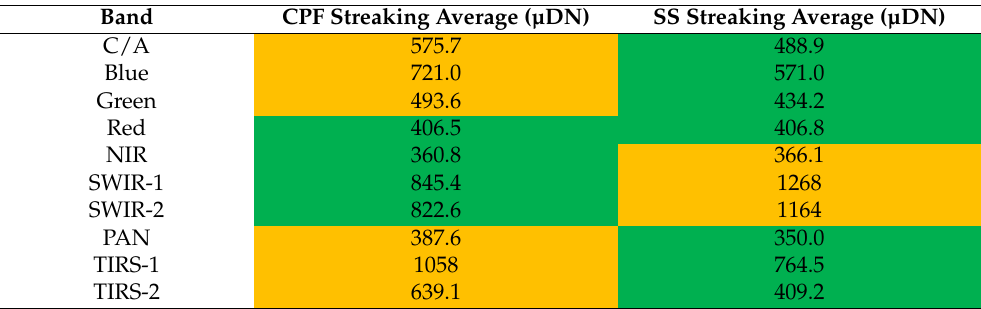
Table 6. Average Streaking Metrics when the best SS relative gain set is applied to Arabian Desert scenes and compared with the operational CPF relative gain sets; yellow cells contain statistically worse data than green cells; if multiple cells are the same color that data is statistically equal, as proven by the t -test. CPF Streaking Average